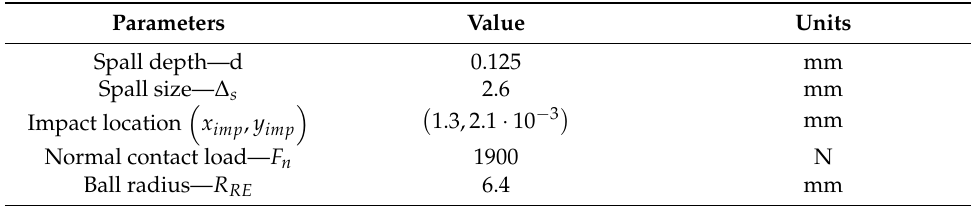
Table 1. FE model